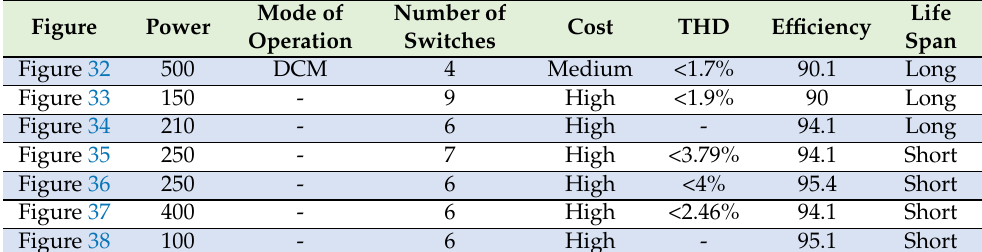
Figure 37. Full bridge resonant converter with three phase inverter. Table 5. Comparison of multi-stage isolated PV micro